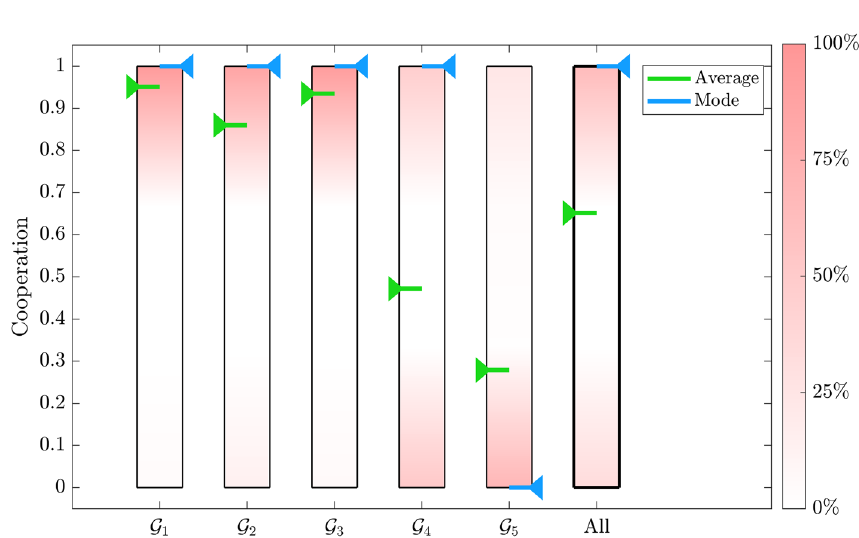
Figure 5. Comparison of standardized dataset ˆ σ I with standardized simulation ˆ σ X V .